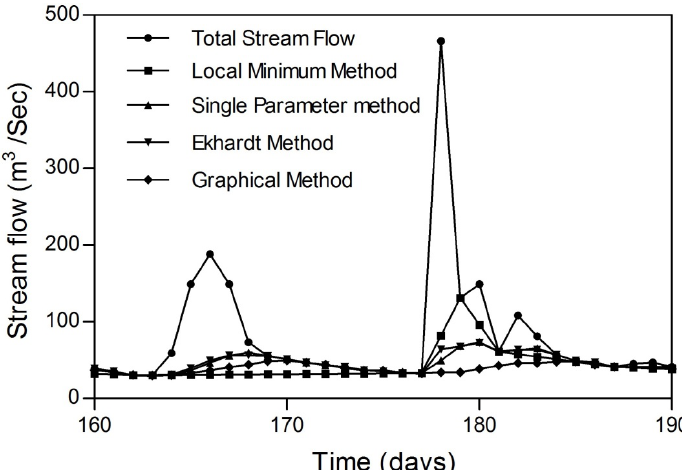
Figure 7. The base-flow separation